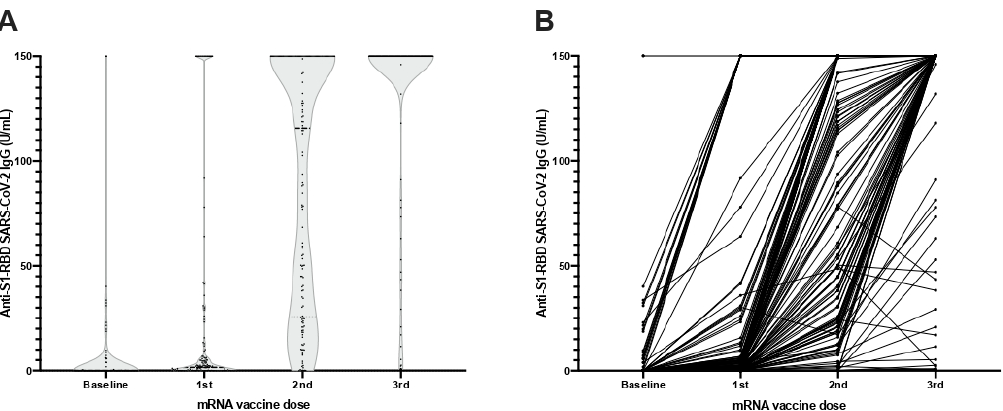
Figure 3. Anti-S1-RBD IgG levels at baseline and after each dose with any SARS-CoV-2 mRNA vac- cine A. Violin plots of anti-S1-RBD IgG levels. B. Before–after plot of anti-S1-RBD IgG levels. vaccine ( A ) Violin plots of anti-S1-RBD IgG levels. ( B ) Before–after plot of anti-S1-RBD IgG